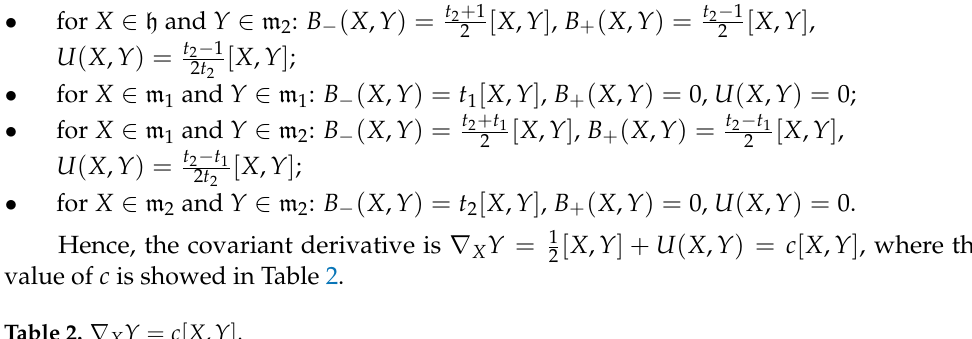
Table 2. ∇ X Y = c [ X , Y ]